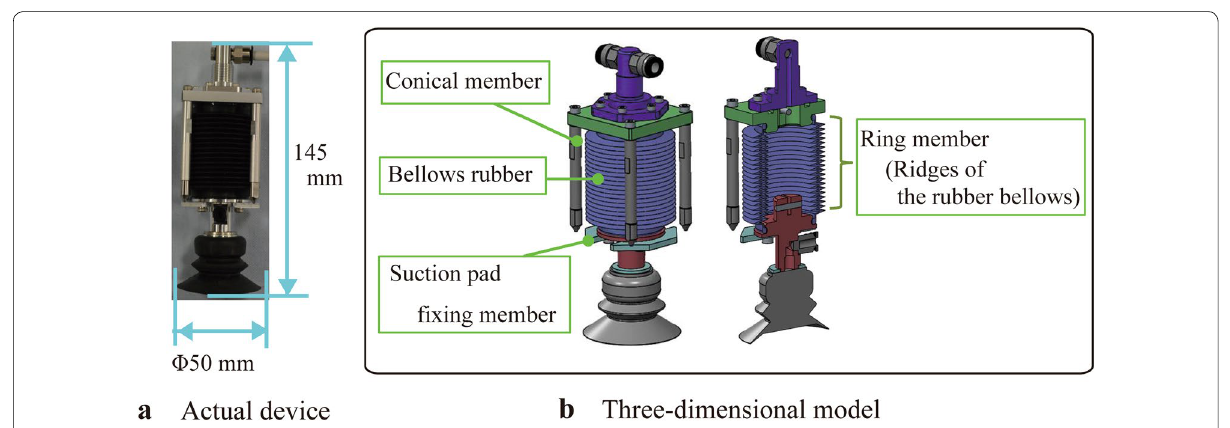
Fig. 9 Reduction state of developed suction pad unit. a Actual device, b three-dimensional model